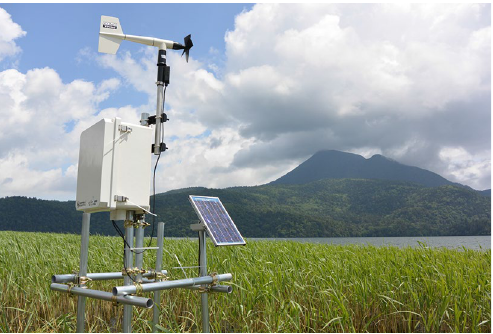
Figure 10. Meteorological station for measuring wind speed and direction at Churui Bay in Lake Akan.